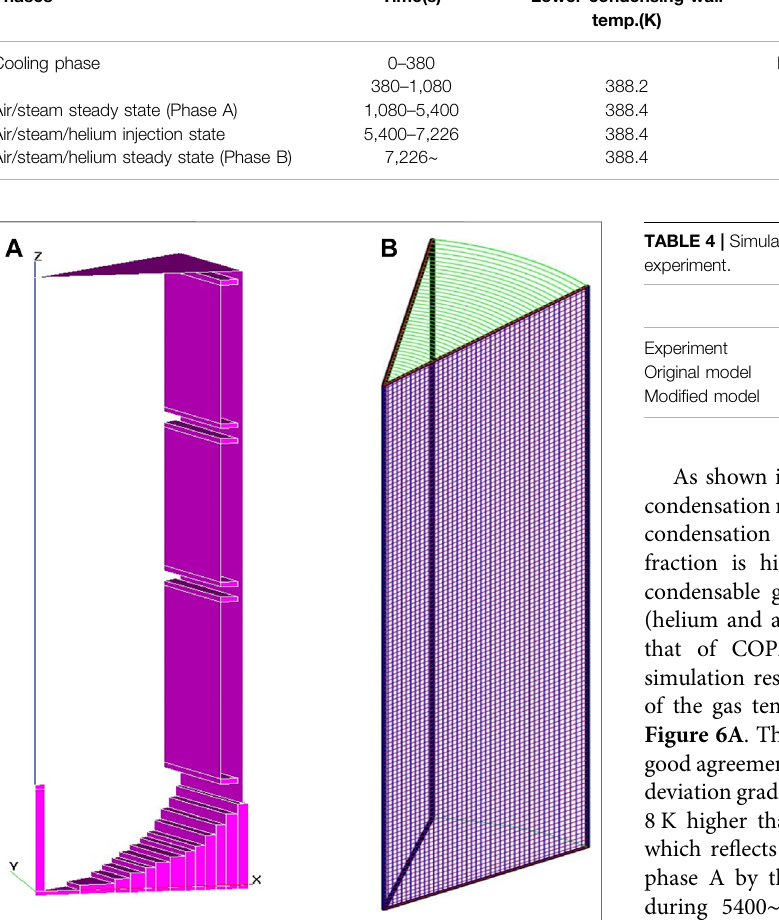
FIGURE 5 | Diagram of MISTRA test section and mesh. (A) Geometry. (B) Mesh.